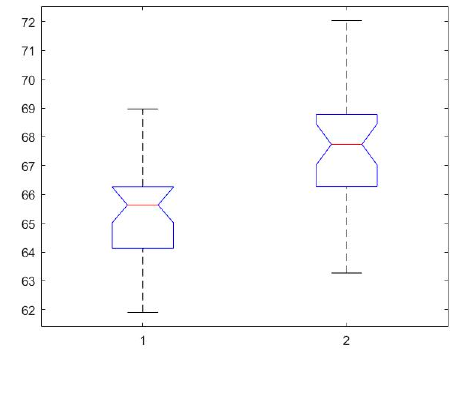
3. POCID indicator. The result indicates a dissimilarity between the POCID values, the one corresponding to the proposed method being significantly better.